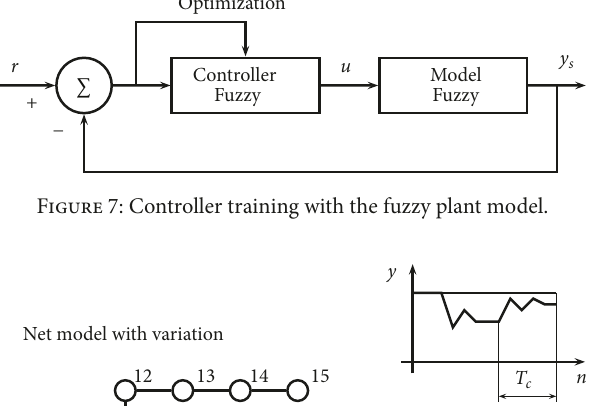
Figure9:Systemoperationafterthesecondcontrolleroptimization.